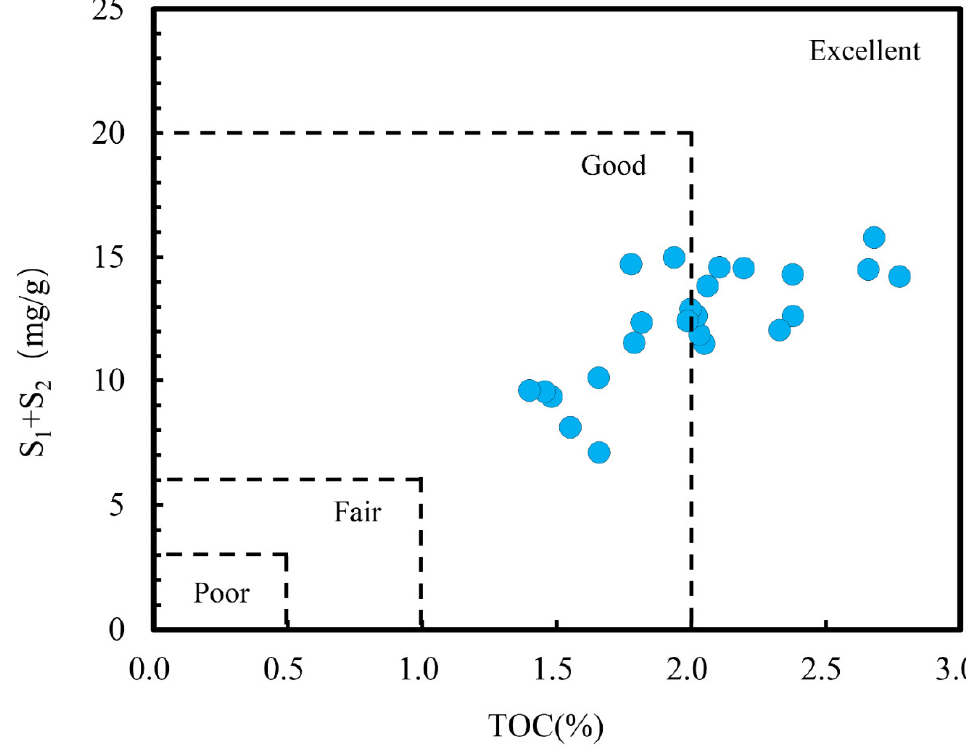
Figure 4. Diagram of TOC vs. (S 1 +S 2 ). Modified after Peters and Cassa (1994) [24]. Table 2. Statistics of geochemical biomarker parameters of the Qingshankou lacustrine shales.